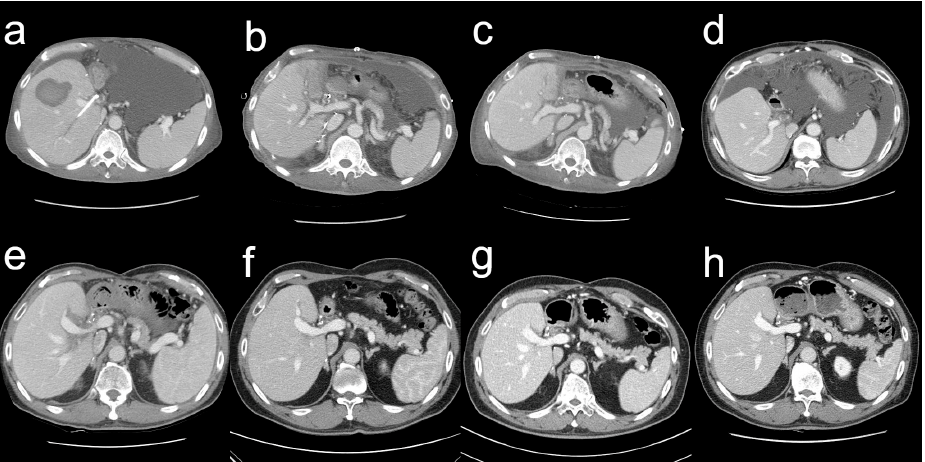
Figure 3. Series CT scans on pre-retransplant day 12 ( a ), postoperative day 10 ( b ), postoperative day 28 ( c ), postoperative month 3 ( d ), postoperative year 1 ( e ), postoperative year 3 ( f ), postoperative year 5 ( g ), and postoperative year 8 ( h ).